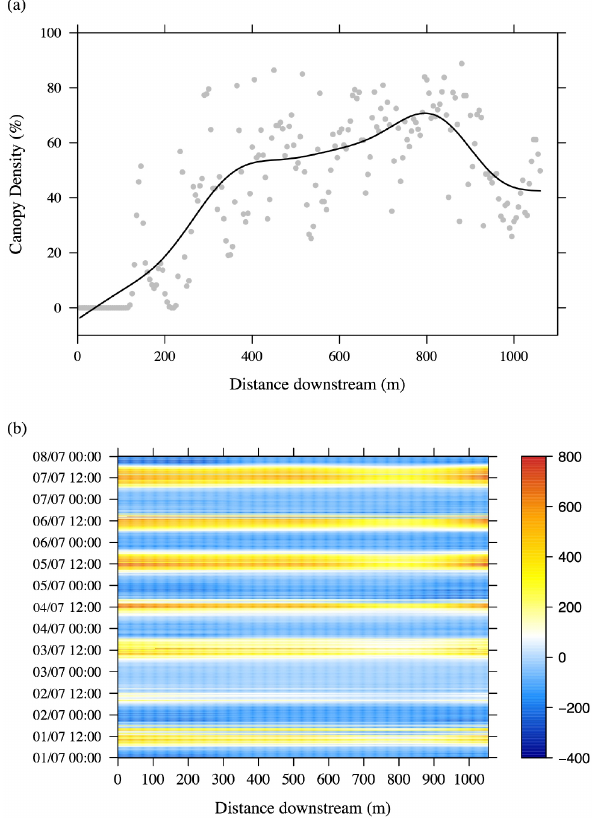
Figure 6. Patterns within the reach in: (a) canopy density (points indicate spot measurements of canopy density obtained from hemi- spherical photographs. Solid line indicates smoothed trend) (b) net energy flux (MJm 2 d − 1 ).